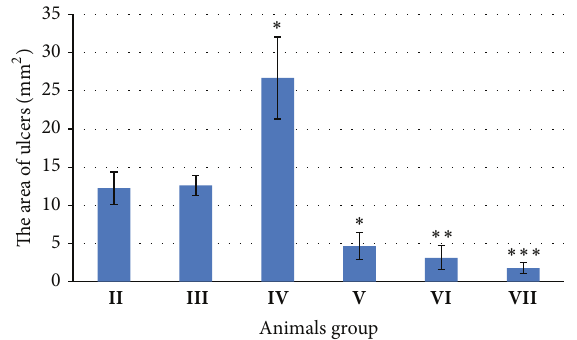
Figure 2: The influence of small-molecule agents 1 , 2 , 3 , and 4 (dose 1mg/kg, intraperitoneally) on the area of gastric mucosa ulceration caused by stress in rats: II : stress-control group; III : stress-control group treated with aqueous DMSO (10 𝜇 L of DMSO in 1mL of saline); IV : compound 1 ; V : compound 2 in aqueous DMSO; VI : compound 3 ; VII : compound 4 in aqueous DMSO. ∗ 𝑃 < 0.05 ; ∗∗ 𝑃 < 0.01 ; ∗∗∗ 𝑃 < 0.001